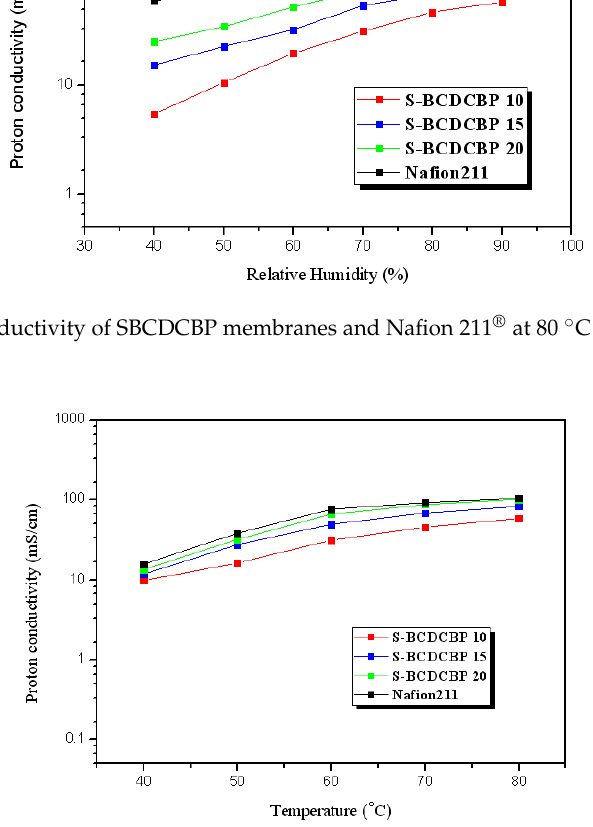
Figure 5. Proton conductivity of SBCDCBP membranes and Nafion 211 ® at varying temperatures and 90% RH.